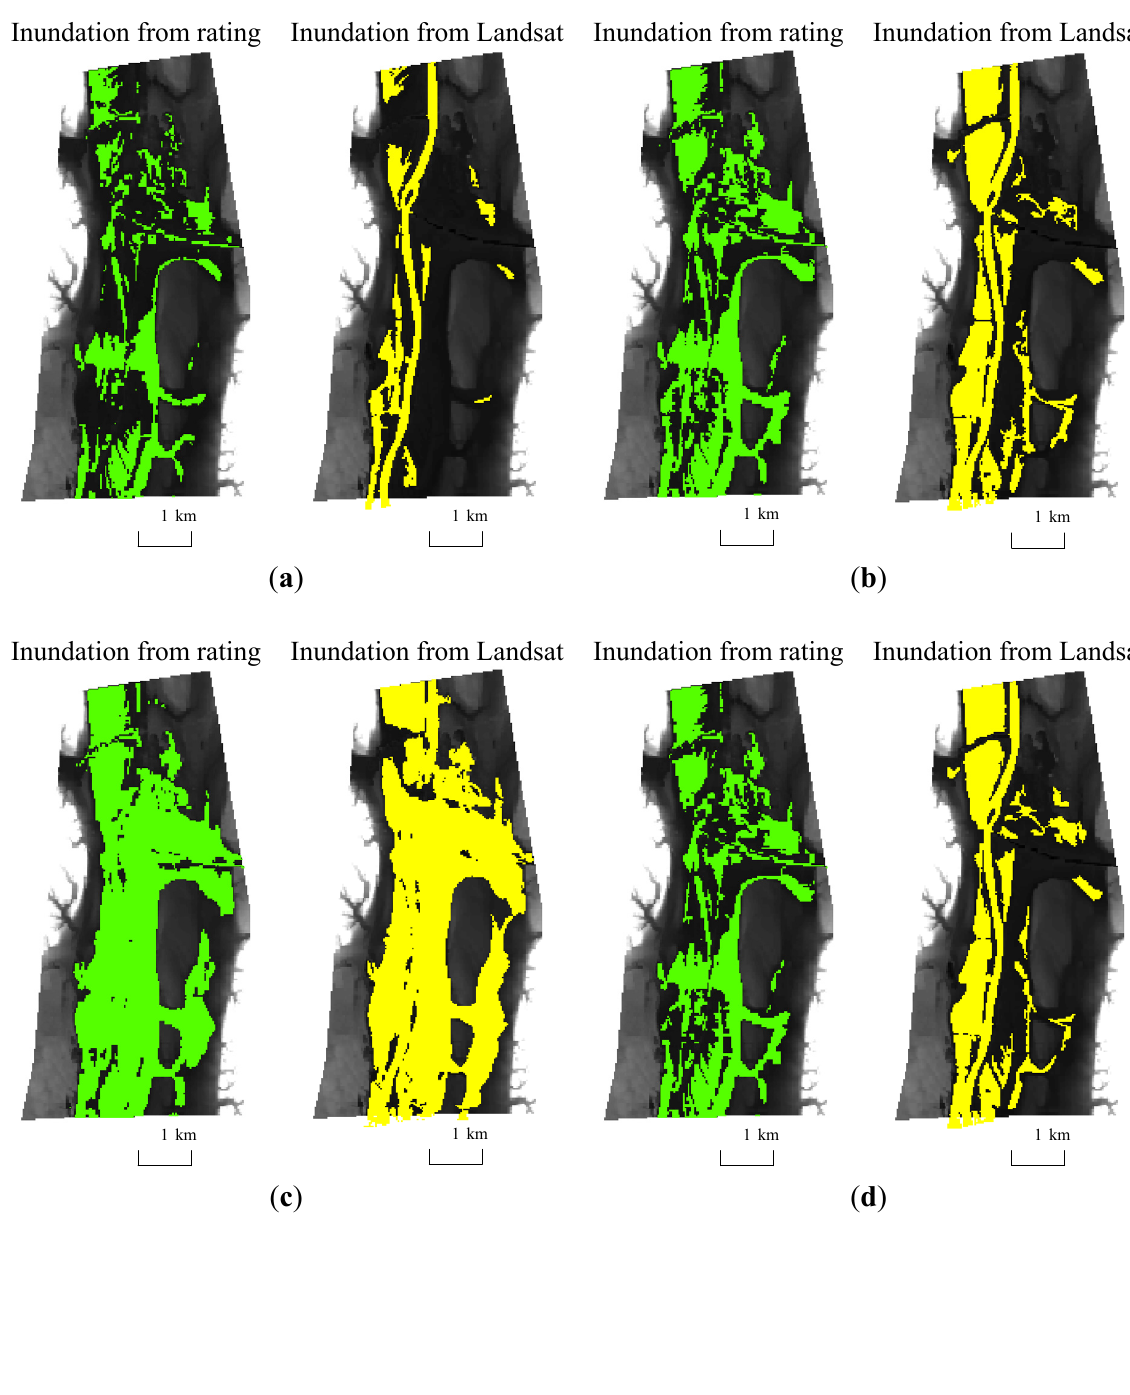
Figure 8. The comparison of inundations from rating equations and from Landsat images for the Montezuma reach. ( a ) Flood flow of 929 m 3 /s on 19 April 2006; ( b ) Flood flow of 1172 m 3 /s on 5 March 2007; ( c ) Flood flow of 1450 m 3 /s on 11 June 2008; ( d ) Flood flow of 1144 m 3 /s on 11 April